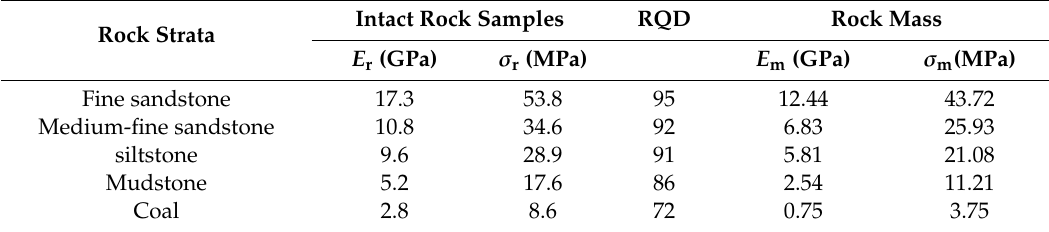
Table 4. Mechanical properties of intact rock and calculated rock mass.